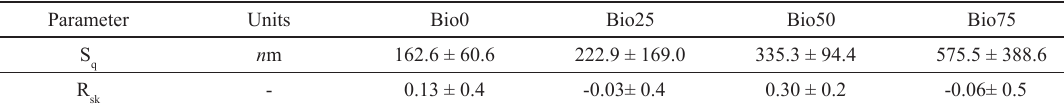
and R . The average results were expressed as mean value and standard deviation. q sk